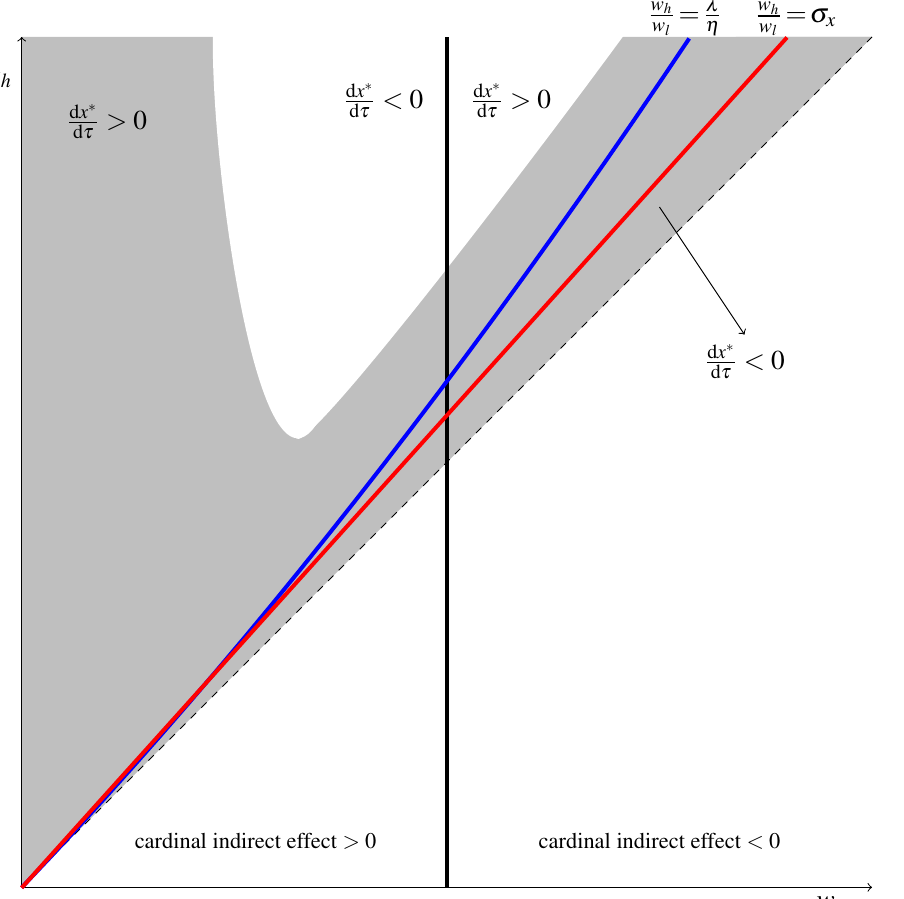
Figure 4: A case where the cardinal status direct effect is negative only for w h / w l > λ / η > σ x , as implied by Result 4. The ordinal status effect is positive for w h / w l > σ x , so when λ / η > w h / w l > σ x the sum of the cardinal status direct effect and the ordinal status effect is positive. For a sufficiently high value of w h / w l the positive ordinal status effect dominates, while for a sufficiently low value of w h / w l the positive cardinal status direct effect dominates. In either case the sum of the ordinal status effect and the cardinal status direct effect is positive (the shaded area). The sign of d x ∗ / d τ is obtained taking also into account the sign of cardinal status indirect